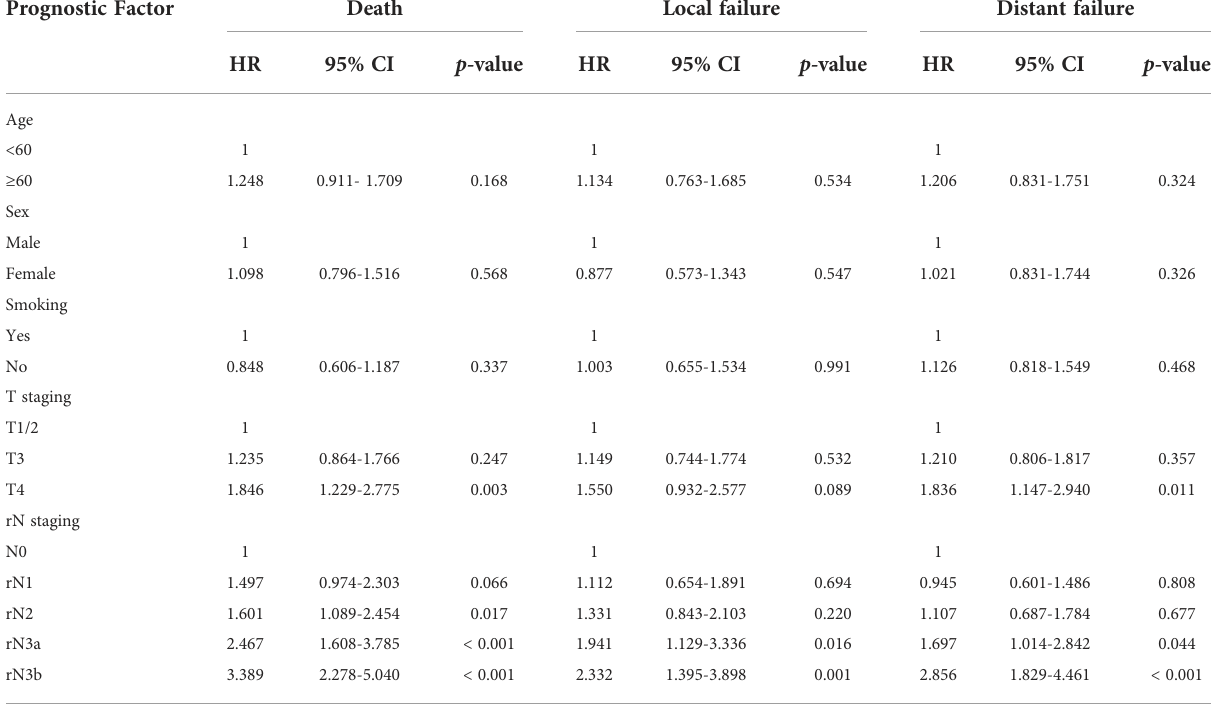
TABLE 5 Effect of rN staging on risk of death, local failure, and distant failure. Prognostic